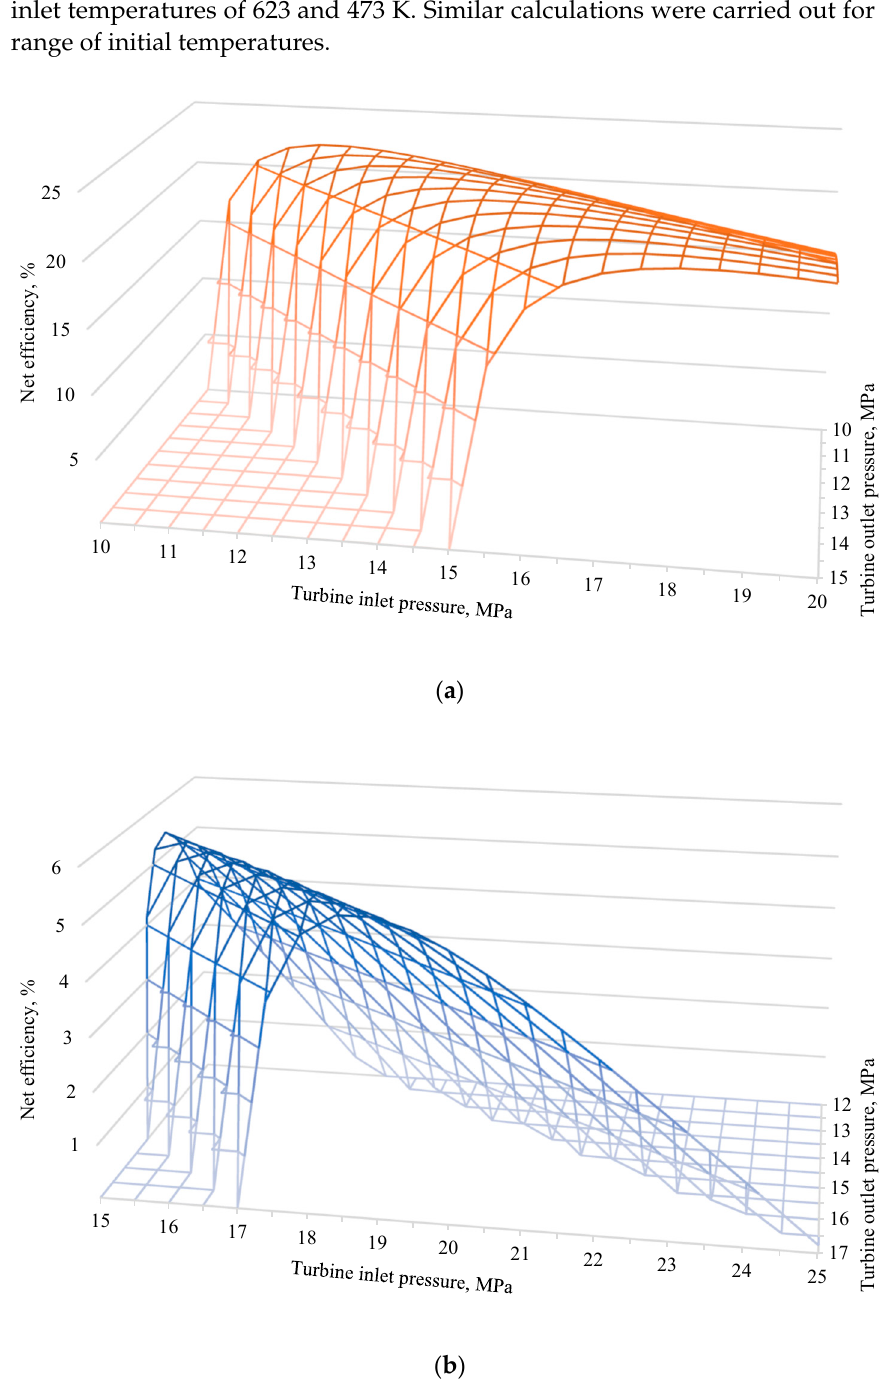
Figure 13. Regenerative Brayton air cycle efficiency dependence on turbine inlet and outlet pressure: ( a ) Turbine inlet temperature of 623 К ; ( b ) Turbine inlet temperature of 473 К .